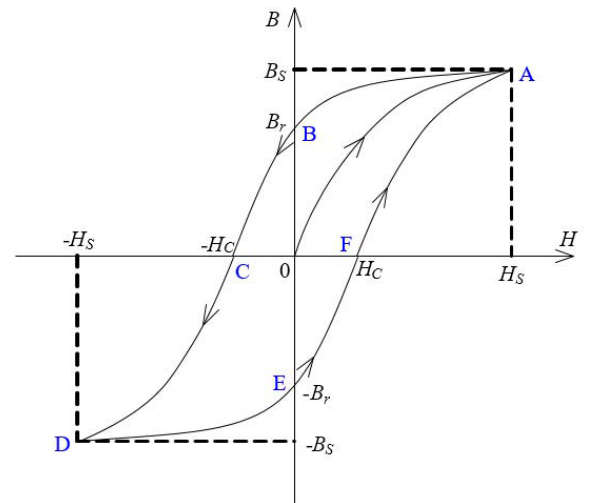
Figure 1. Hysteresis